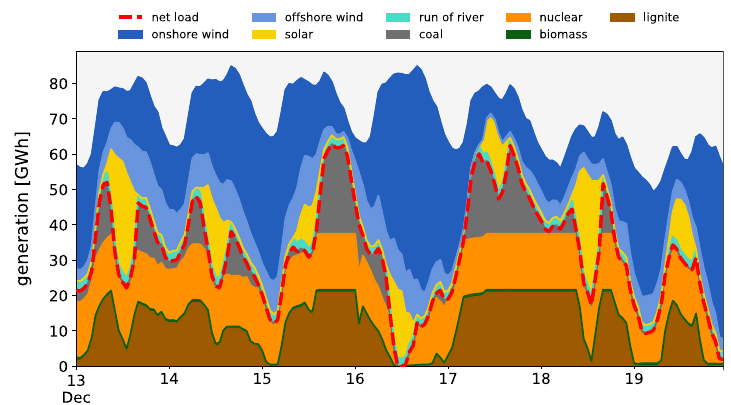
Fig. 3 The generation profile, showing how the different suppliers make up total energy supply, for an exemplary week in our reference future electricity system scenario with a high share of renewable generation. Here, net load is displayed with a dashed red